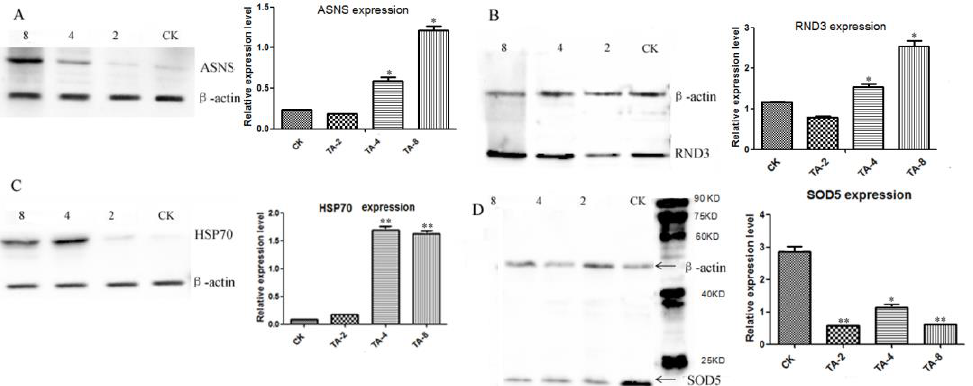
Figure 6. The significantly differentially expressed proteins verified by Western blot after TA treat- ment: ( A ) ASNS; ( B ) RND3; ( C ) HSP70; ( D ) SOD5. Relative expression level refers to the expression level of target proteins compared to that of β - actin. “*” indicates p < 0.05, “**” indicates p < 0.01.